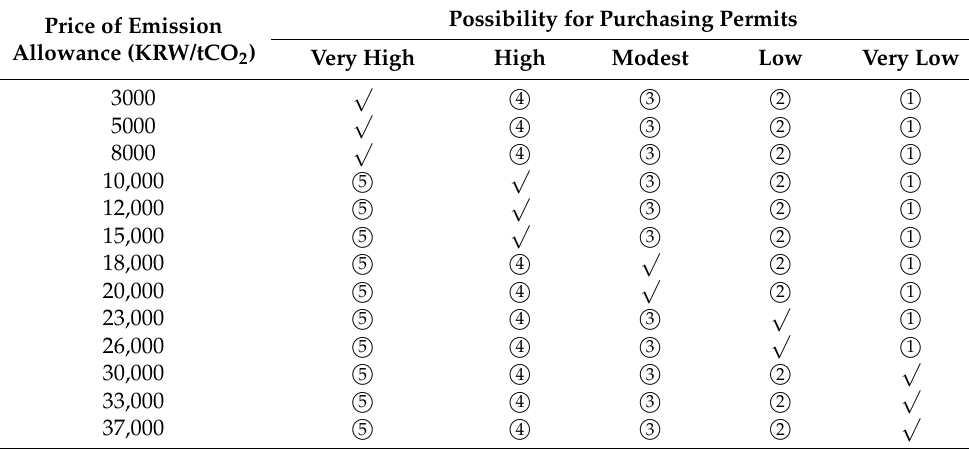
Table 4. Example response in the MBDC